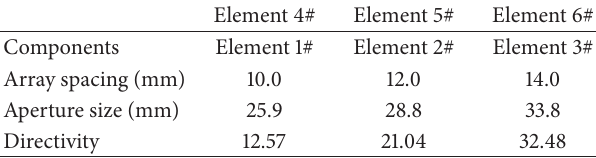
Table 3: Design parameters of proposed element array.